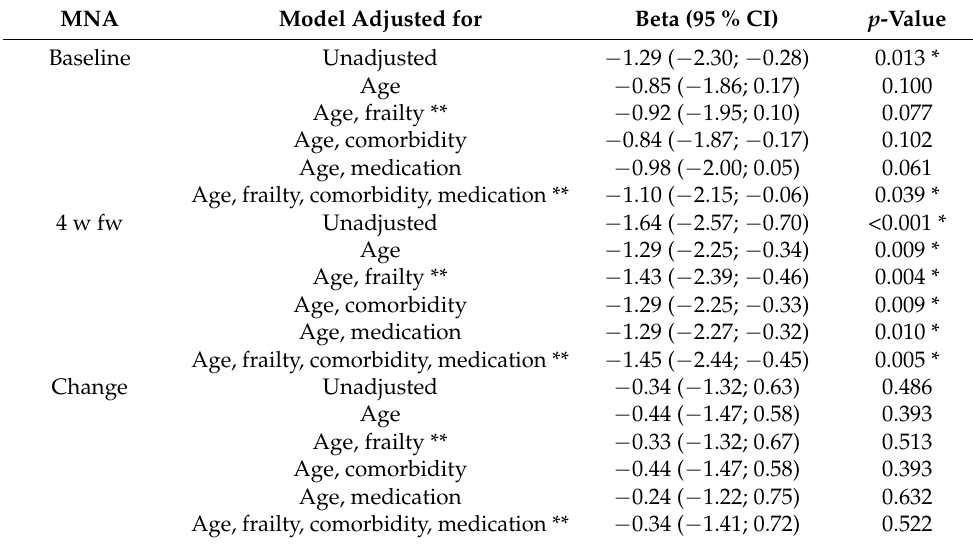
Table 2. The difference in nutritional status (MNA-SF score) between participants with mild cognitive impairment compared to participants with intact cognition at baseline, 4-week follow-up, and the change between baseline, and 4-week follow-up (change) ( n = 89).